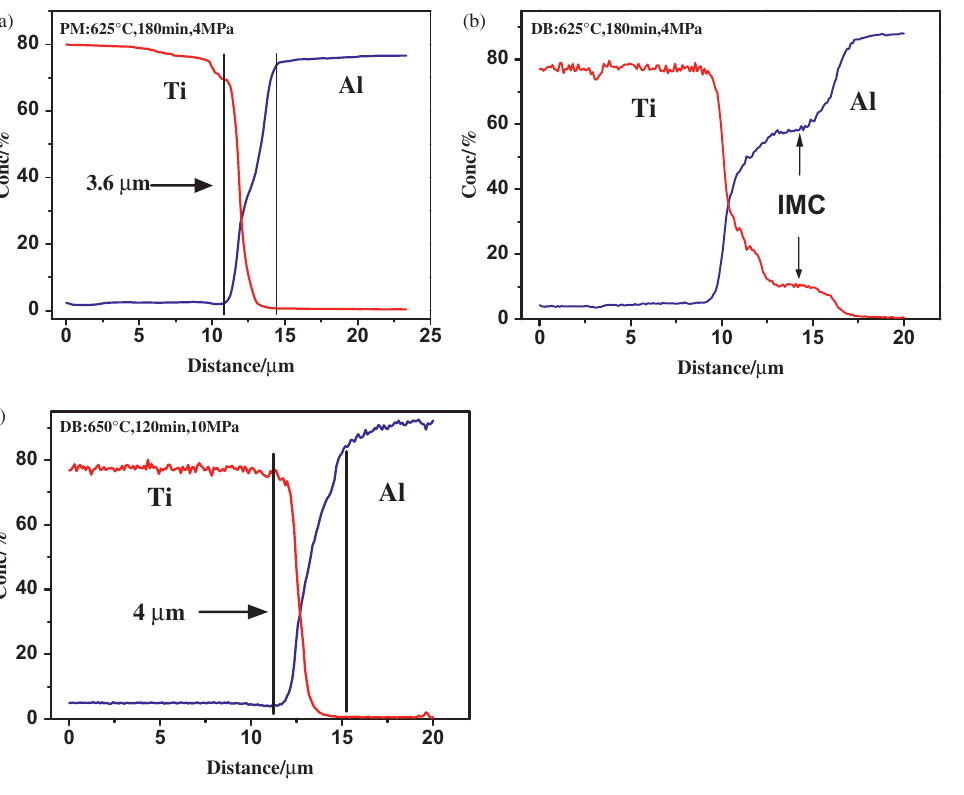
Figure 4: The elemental distributions at the interface region of Ti/Al bonds by different methods (a) P/M; (b) and (c) DB.